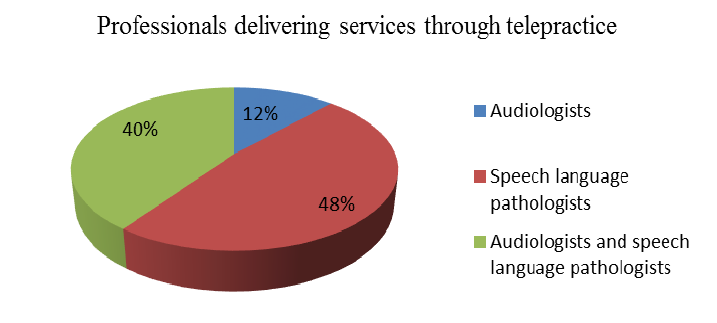
Figure 1. Professionals delivering services through telepractice (N=